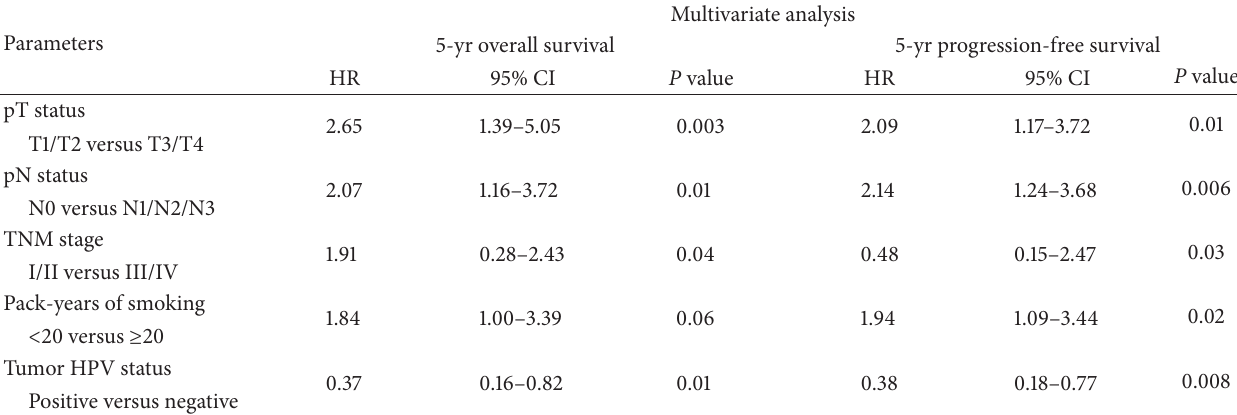
Table 4: Multivariate Cox analysis for 5-year survival and progression-free survival in the study patients with esophageal squamous cell carcinoma.